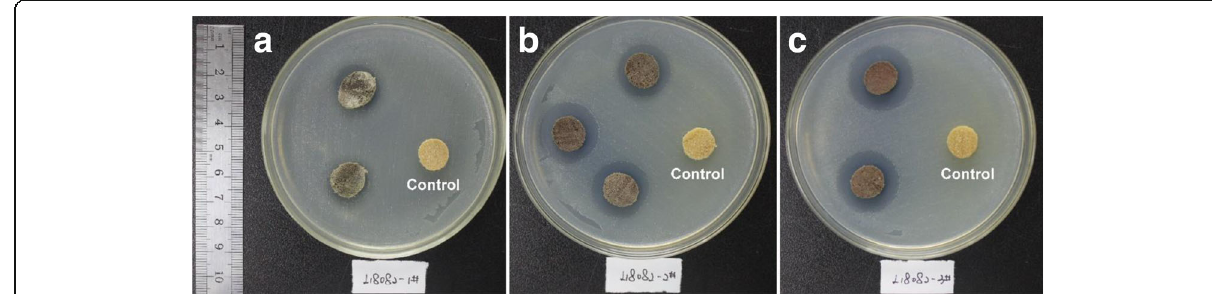
Fig. 9 Antibacterial testing of original wood and hybrid wood materials. a Group C. b Group E. c Group